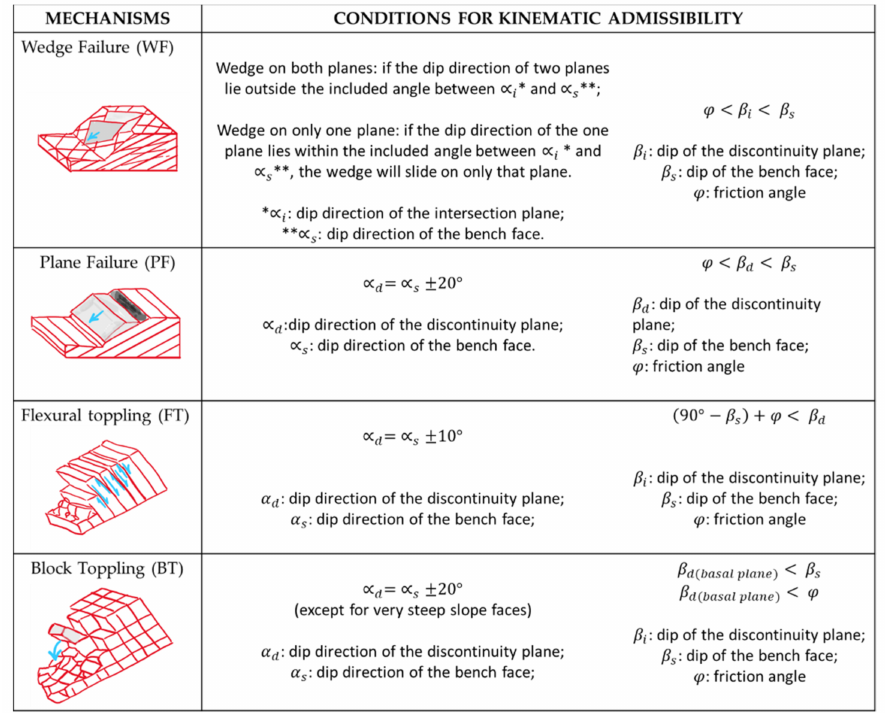
Figure 13. Main mechanisms of rock instability and kinematic conditions for structurally controlled failures occurrence ( α d = discontinuity dip direction, α s = slope dip direction, β d = discontinuity dip angle, β s = slope dip angle, ϕ = friction angle)